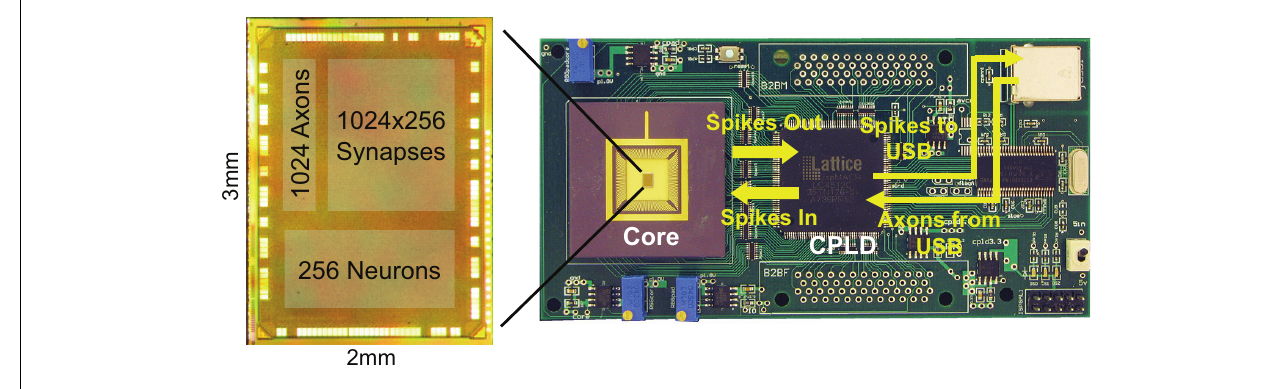
FIGURE 3 |The fabricated chip on the test board. Spike events are sent to a PC via a USB 2.0 link and may also be routed back to the